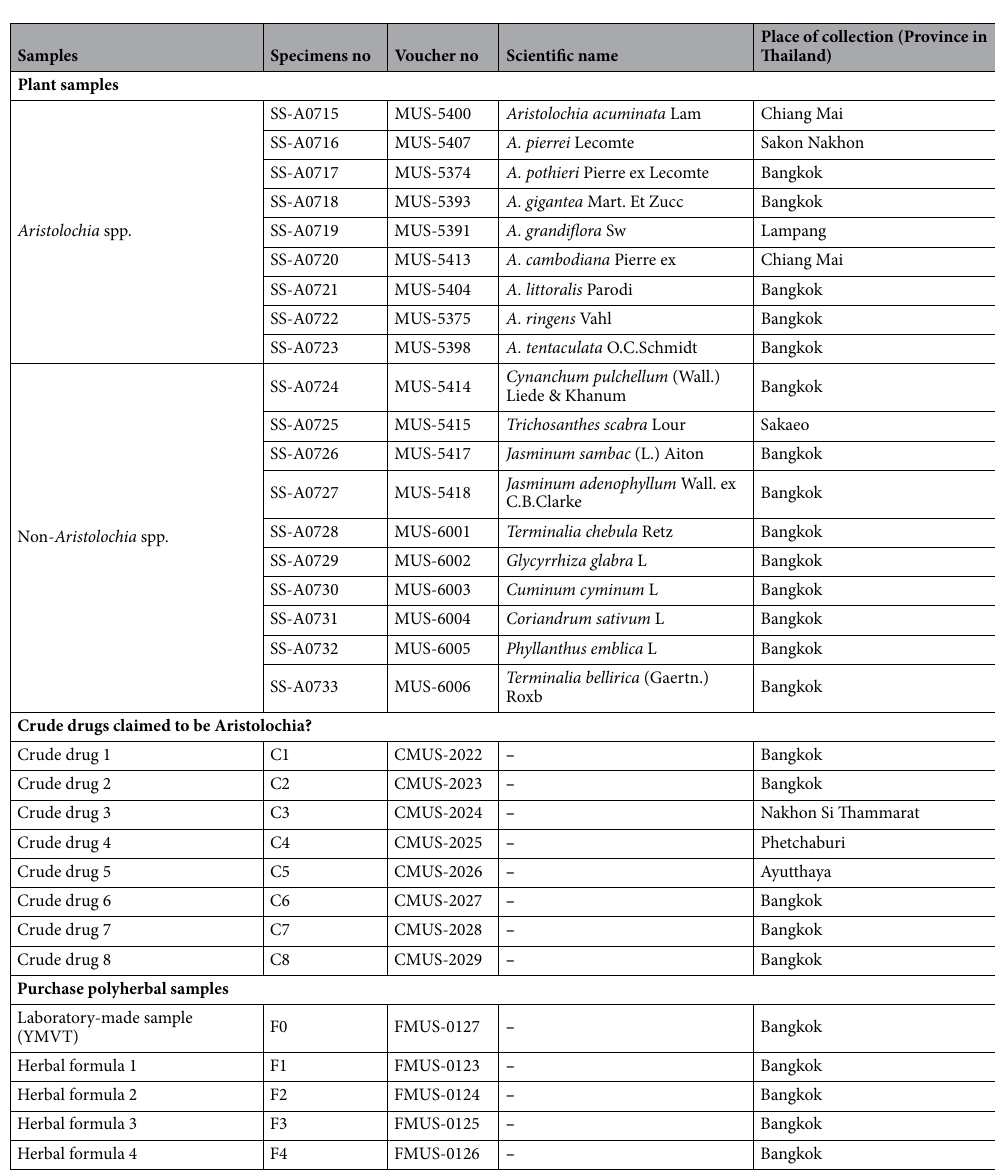
Table 1. Plant materials used in this